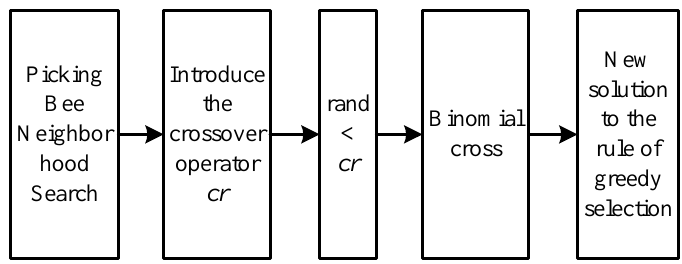
Figure 11. Operation steps of the cross section.